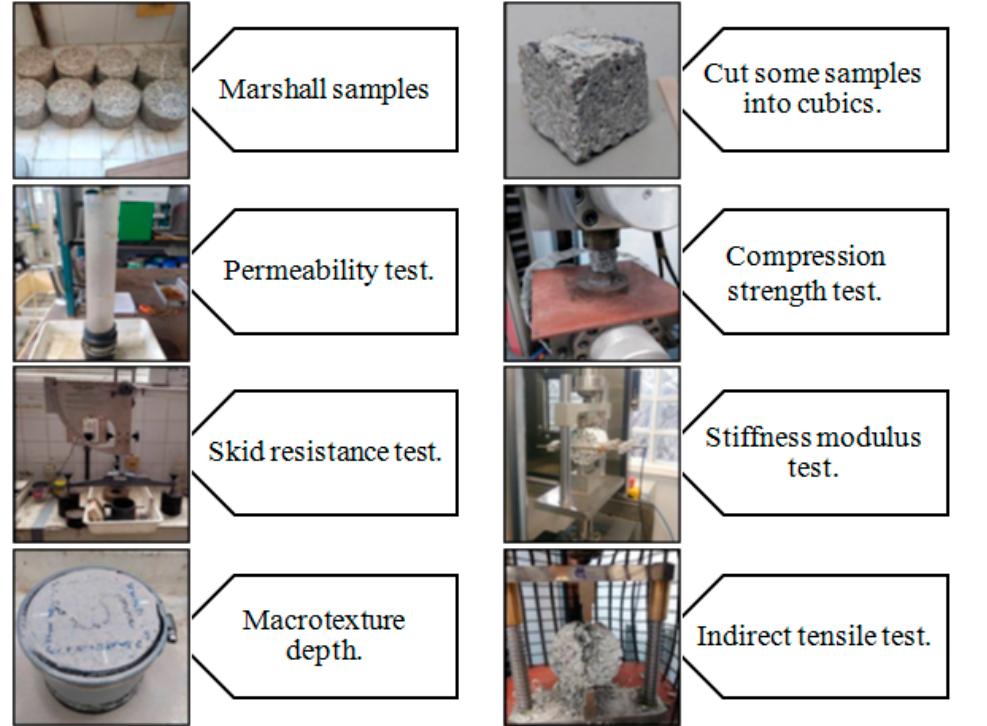
Figure 3. Scheme of research to perform the present investigation.